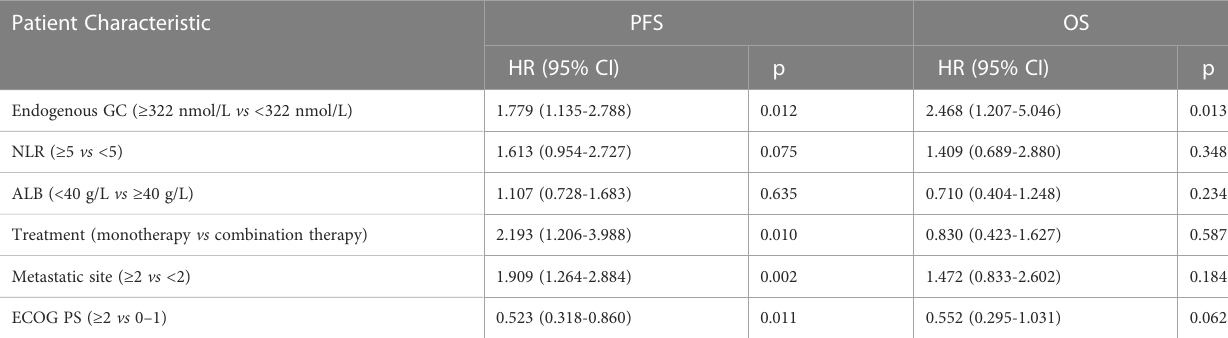
TABLE 2 Multivariable analysis of progression-free survival and overall survival.